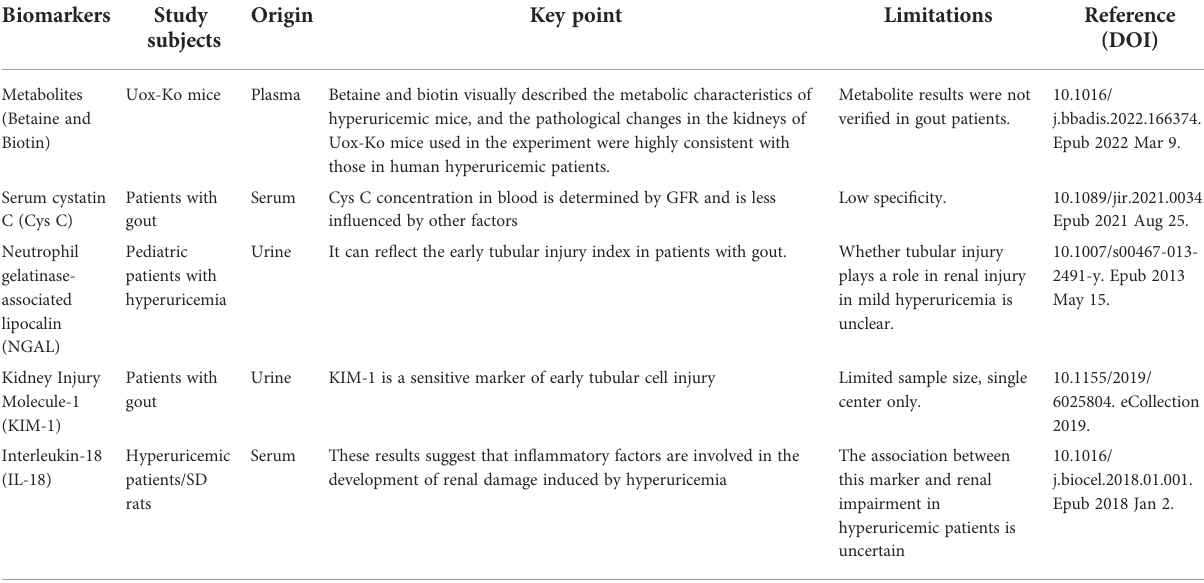
TABLE 1 Early diagnostic biomarkers of gout renal